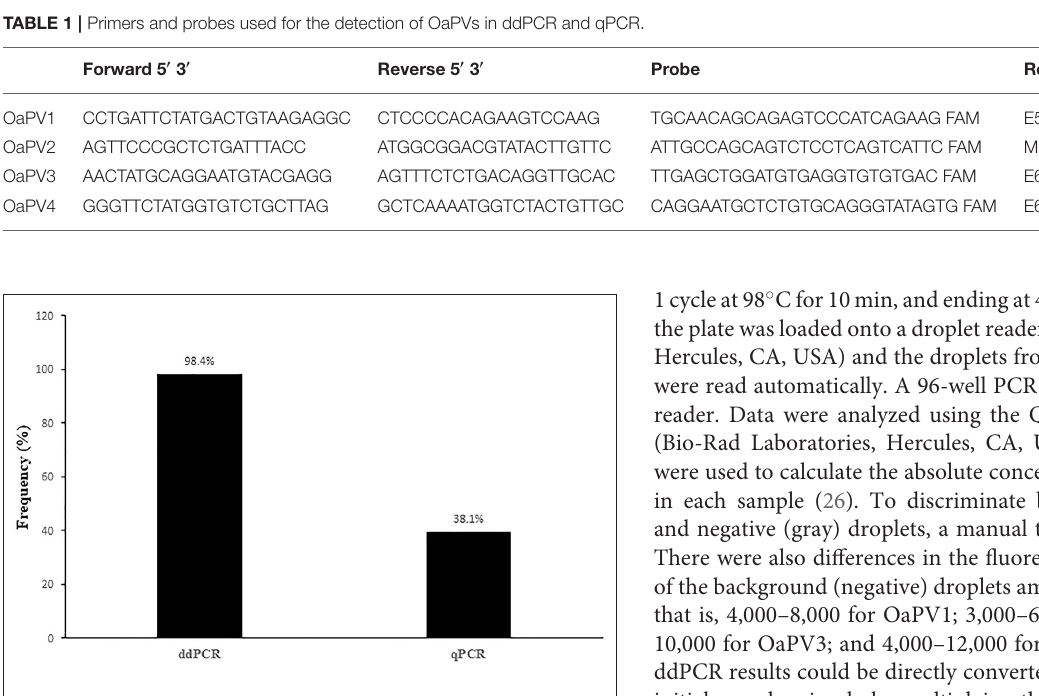
for 2 min, 95 ◦ C for 10 min, and 40 cycles of 95 ◦ C for 15